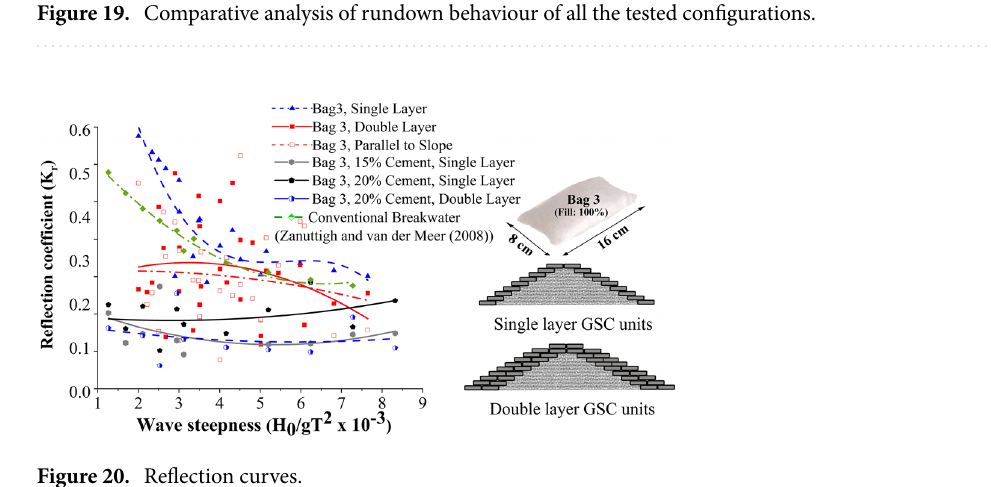
Figure 19. Comparative analysis of rundown behaviour of all the tested configurations.